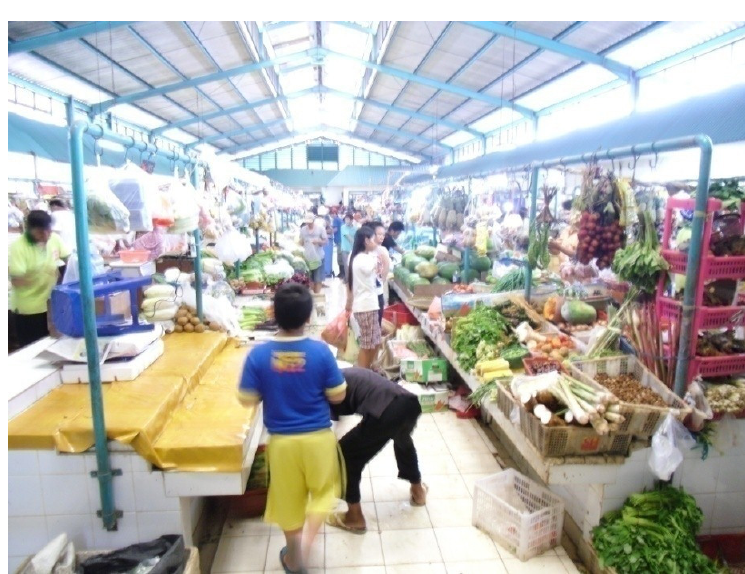
Figure 3. The atmosphere of the Puri Market in